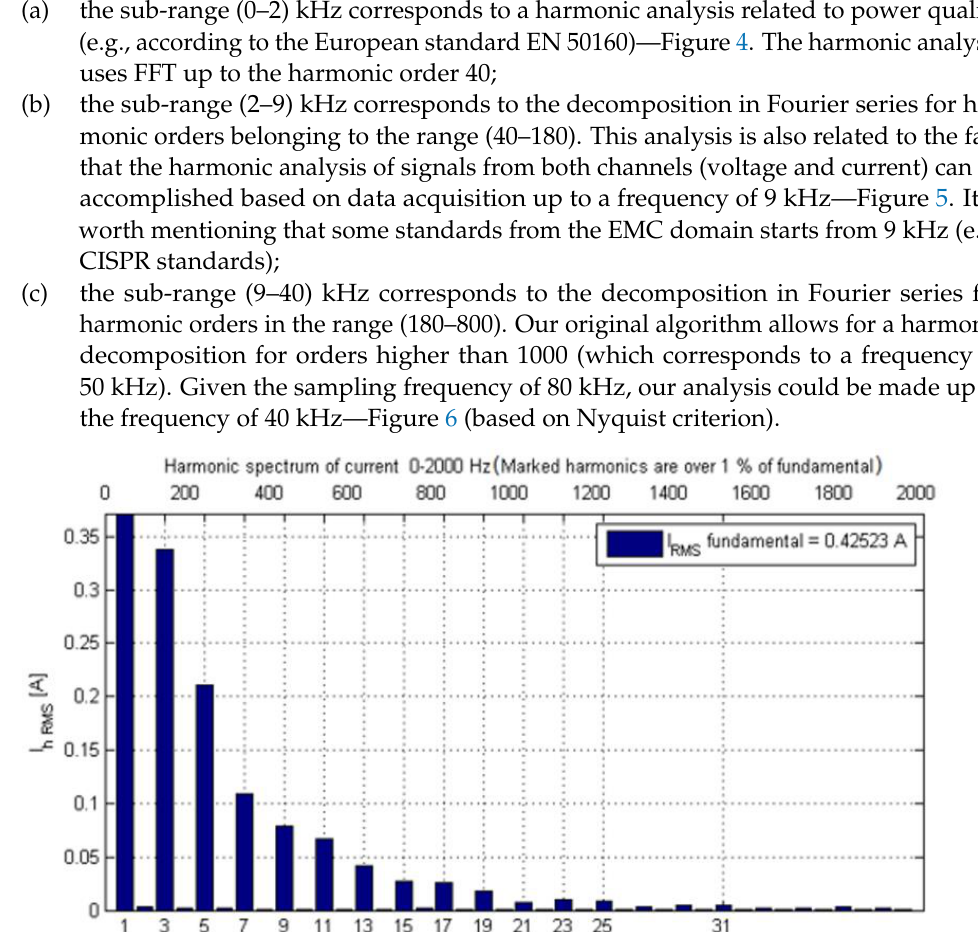
Figure 3. Three period (60 ms) acquired at a sampling frequency of 80 kHz: ( top ) — voltage; ( bot- tom ) — current [16].